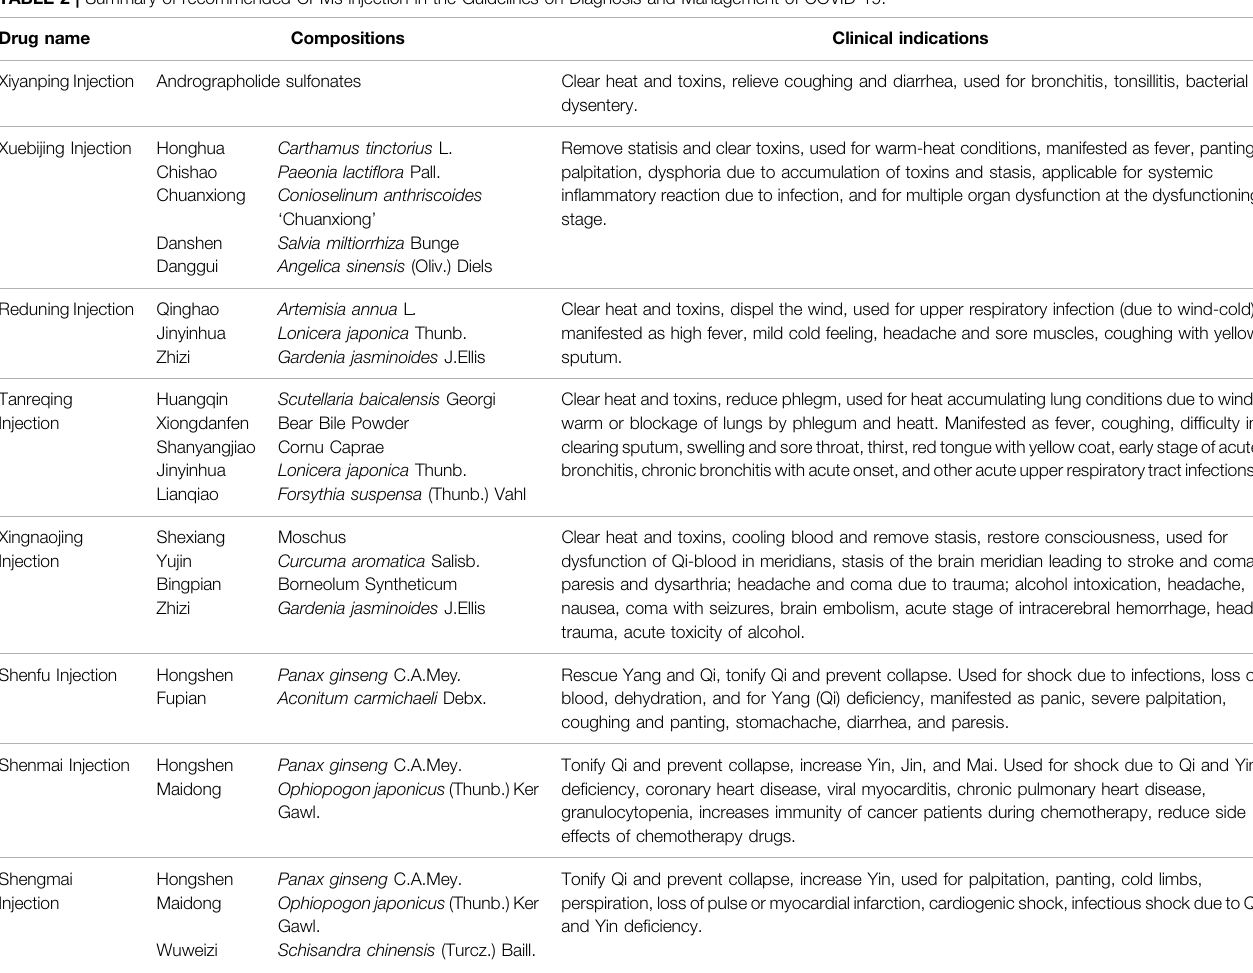
TABLE 2 | Summary of recommended CPMs injection in the Guidelines on Diagnosis and Management of COVID-19. Drug name